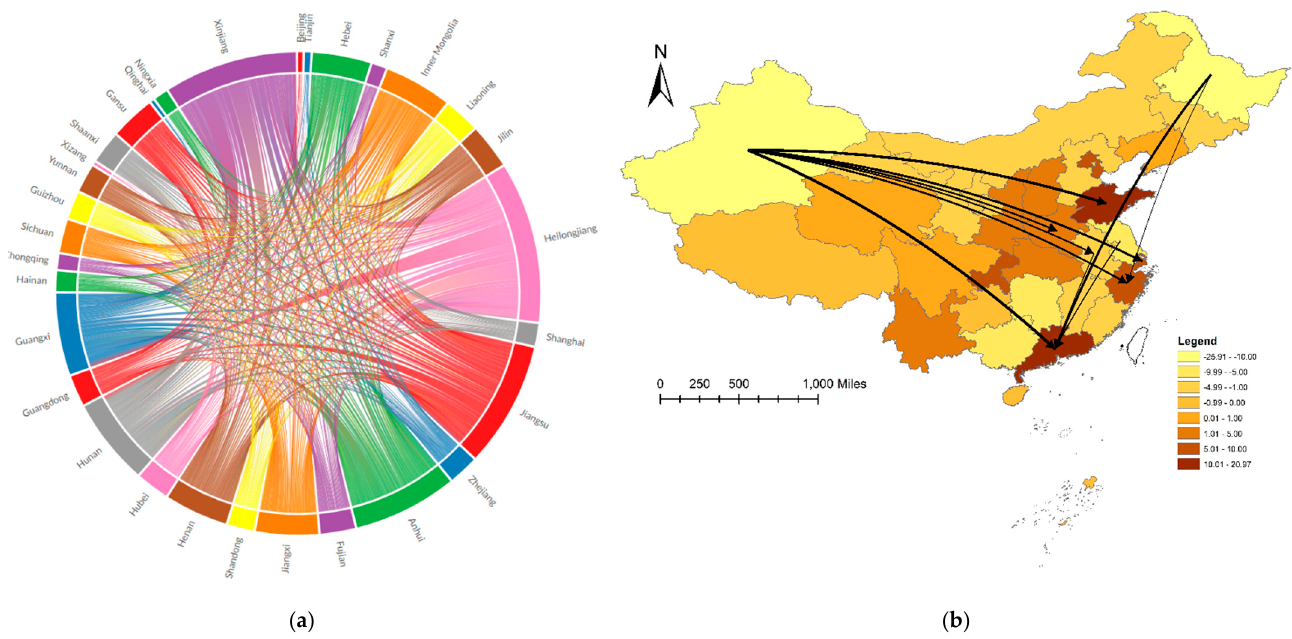
Figure 2. Virtual water trade pattern (a) and the main virtual water flow routes (b) . Note: The regions with one color inside the circle are exporters, and the others are importers; the regions with one color inside the circle represent export; the arrows indicate the virtual water flow direction of the top 10 virtual water trade routes.